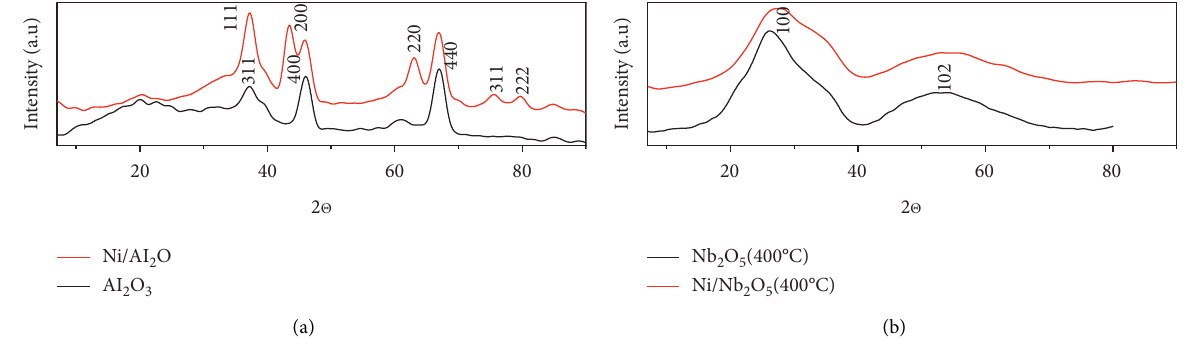
Figure 3: X-ray diffractogram of Al 2 O 3 and Nb 2 O 5 , Ni/Al 2 O 3 , and Ni/Nb 2 O 5